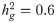
Effect of number of causal SNPs in B-LORE fine-mapping accuracy.We simulated 13082 phenotypes using 100 loci of ∼200 SNPs, as described in the main text. Panels (a)—(d) show the results using different hypothetical distributions of true causal SNPs in each simulation The distributions of the true causal SNPs were generated ad hoc and are shown in the inset of every panel. All simulations used hg2=0.6. We compared the ranking of SNPs at each locus by B-LORE and FINEMAP using recall (solid lines, left y-axis) averaged over the loci and the simulation replicates. Both methods were run with different number of causal SNPs allowed in the model (‖c‖1, see legends). FINEMAP was run on each locus separately and B-LORE was run on all loci together. For each method, we stopped increasing ‖c‖1 if the recall did not improve. The symbols are merely visual guides to distinguish between the different methods.